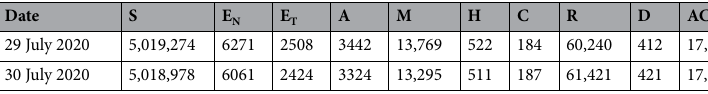
Table 2. Oman Dataset.